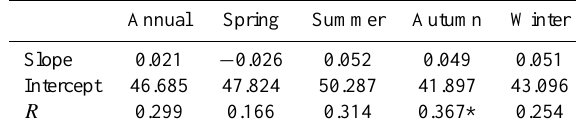
Table 5. Linear regression coefficients of annual and seasonal dif- fuse fraction from 1981 to 2010 for annual diffuse